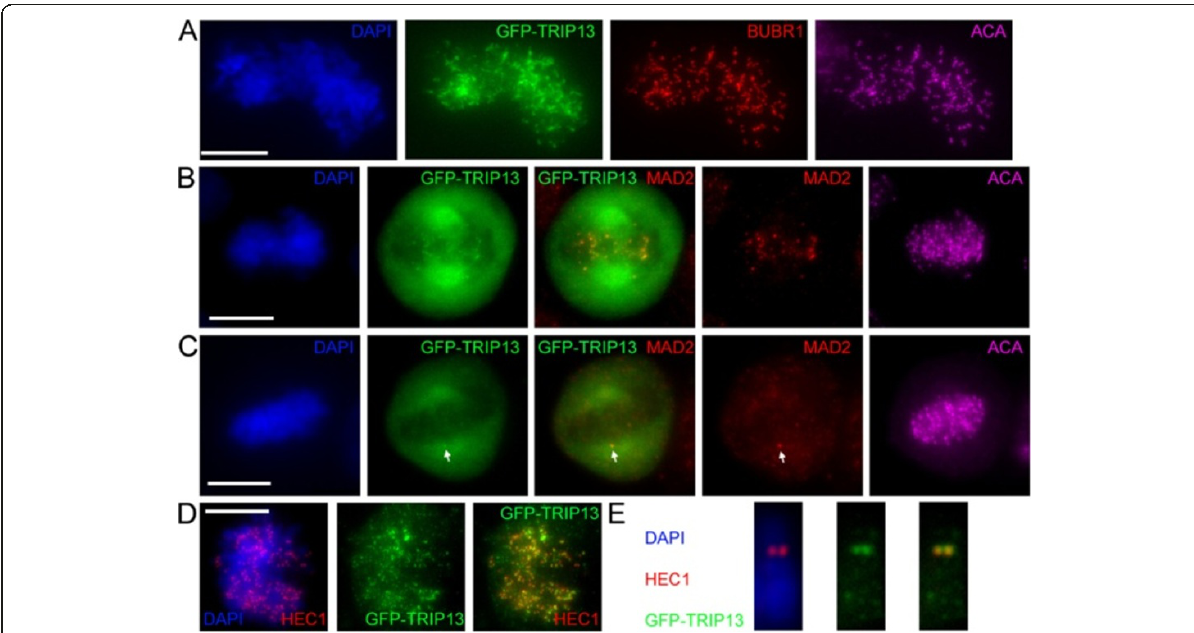
Figure 2 Characterization of novel kinetochore protein TRIP13. ( A ) A GFP-TRIP13 transfected HeLa cell in early prometaphase was stained for centromeres (ACA, purple), BUBR1 (red) and DNA (DAPI, blue) to compare with the GFP signals (green). Images shown are maximum projection of a z-series at 1 μ m interval. Bar=10 μ m.(B&C) A GFP-TRIP13 transfected prometaphase cell ( B ) and a cell progressing into metaphase ( C ) were co-stained with anti-MAD2 antibody and ACA to show GFP-TRIP13 localization only at MAD2 positive kinetochores, such as the one indicated by arrows in ( C ).( D ) A GFP-TRIP13 transfected cell spun onto a coverslip for mitotic chromosome spread preparation was probed with DAPI and anti-HEC1 antibody. ( E ) A single mitotic chromosome stained with DAPI, anti-GFP and anti-HEC1 antibodies to show kinetochore localization of